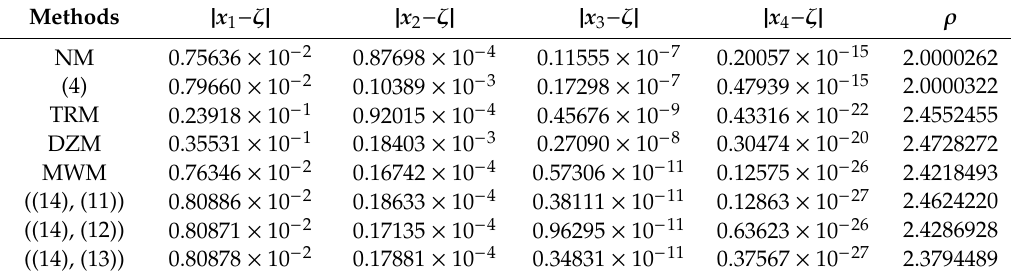
Table 4. Numerical results for function f 4 ( x ) .